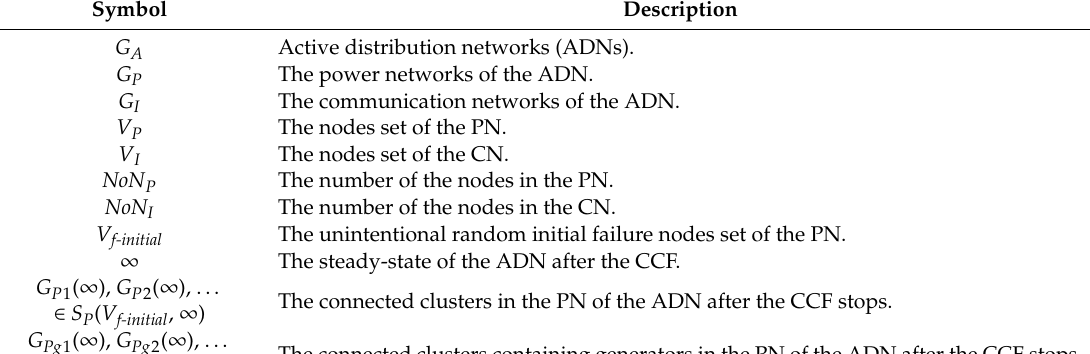
Table 1. Notation used in this